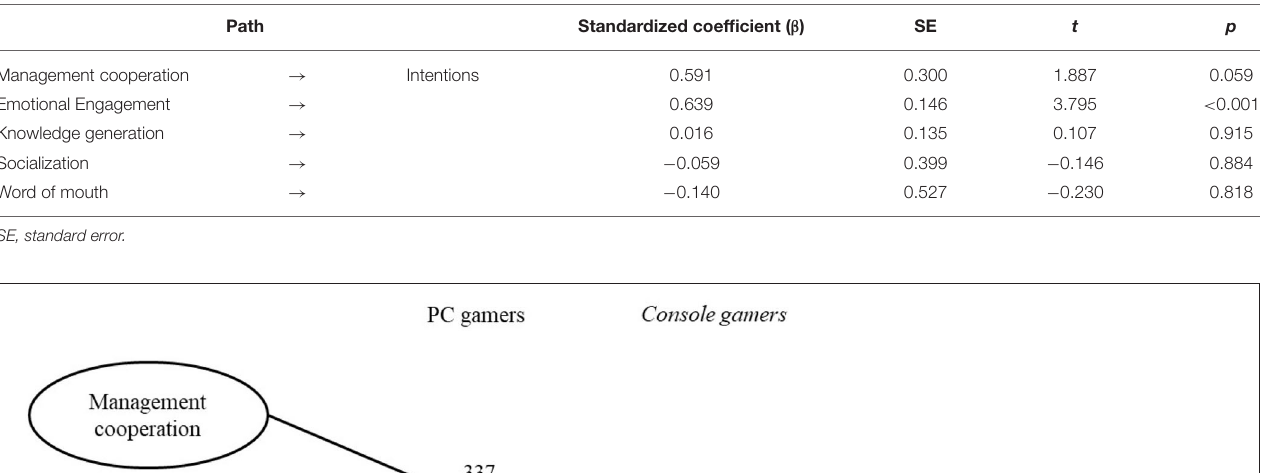
each year (Copenhaver and Griffin, 2021). Whereas, PC games are often maintained—independent of video developers and producers—by game modders. Video game modding (short for modification) refers to altering how a game looks or behaviors, with the intent to extend the replay and hedonic value of a game (Poor, 2014). As such, video game console based esports team fans are more likely to want to support their favorite game developers and producer, whereas PC based gamers are more independent from